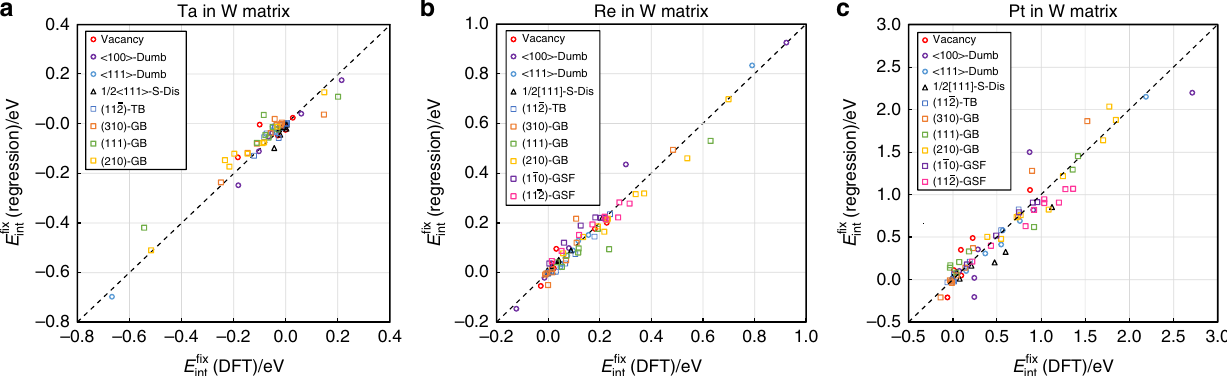
E int (DFT)/eV fix E int (DFT)/eV fix from DFT calculations and predicted from Eq. (1) in the W binary alloys. a W – Ta system; b W – Re system; c W – Pt Fig. 3 Comparison between the E fix int system. The data of the point, line, and planar defects are marked in circle, triangle, and square symbols, respectively. The DFT-calculated E fix refers to the int solute – defect interaction energies calculated based on fi xed atomistic structures that are already fully relaxed in pure W. In the legend, Dumb refers to the abbreviation of the dumbbell defects, S-Dis refers to the abbreviation of the 1 111 h i screw dislocation, TB refers to twin boundaries, GB refers to grain 2 boundaries, and GSF refers to generalized stacking faults. The values of the Δ dip and x sp of each defect site used for the linear regression are listed in Supplementary Table 2. The regression parameters for each matrix – solute element pair are summarized in Table